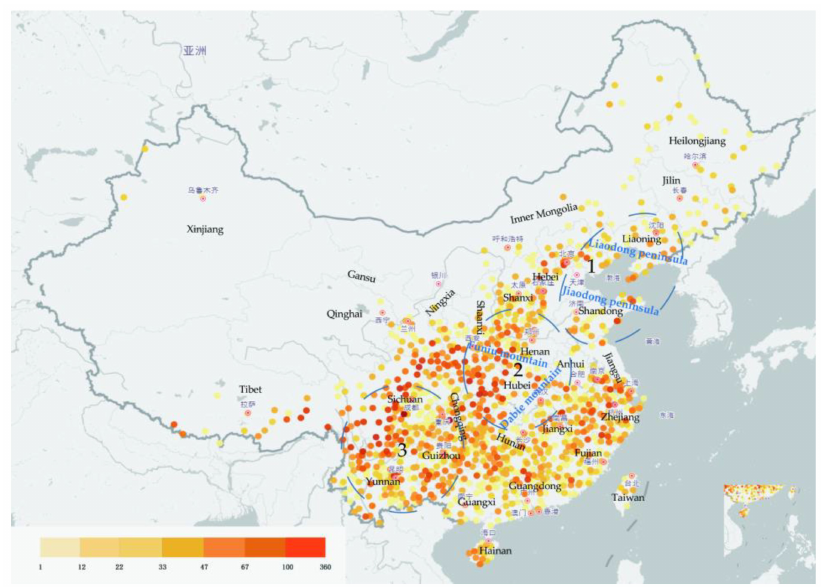
Figure 1. Oak distribution in China based on occurrence records obtained from the National Specimen Information Infrastructure database (www.nsii.org.cn, accessed on 23 December 2022). The different colors represent the collected plant specimen numbers (this reflects the abundance of Quercus samples in this area). Tree concentrated distributions in general areas are also shown in the picture. Two Quercus species, Quercus acutissima and Quercus dentata specimen, have been calculated for the top 20 provinces in a Supplementary Materials (Figure